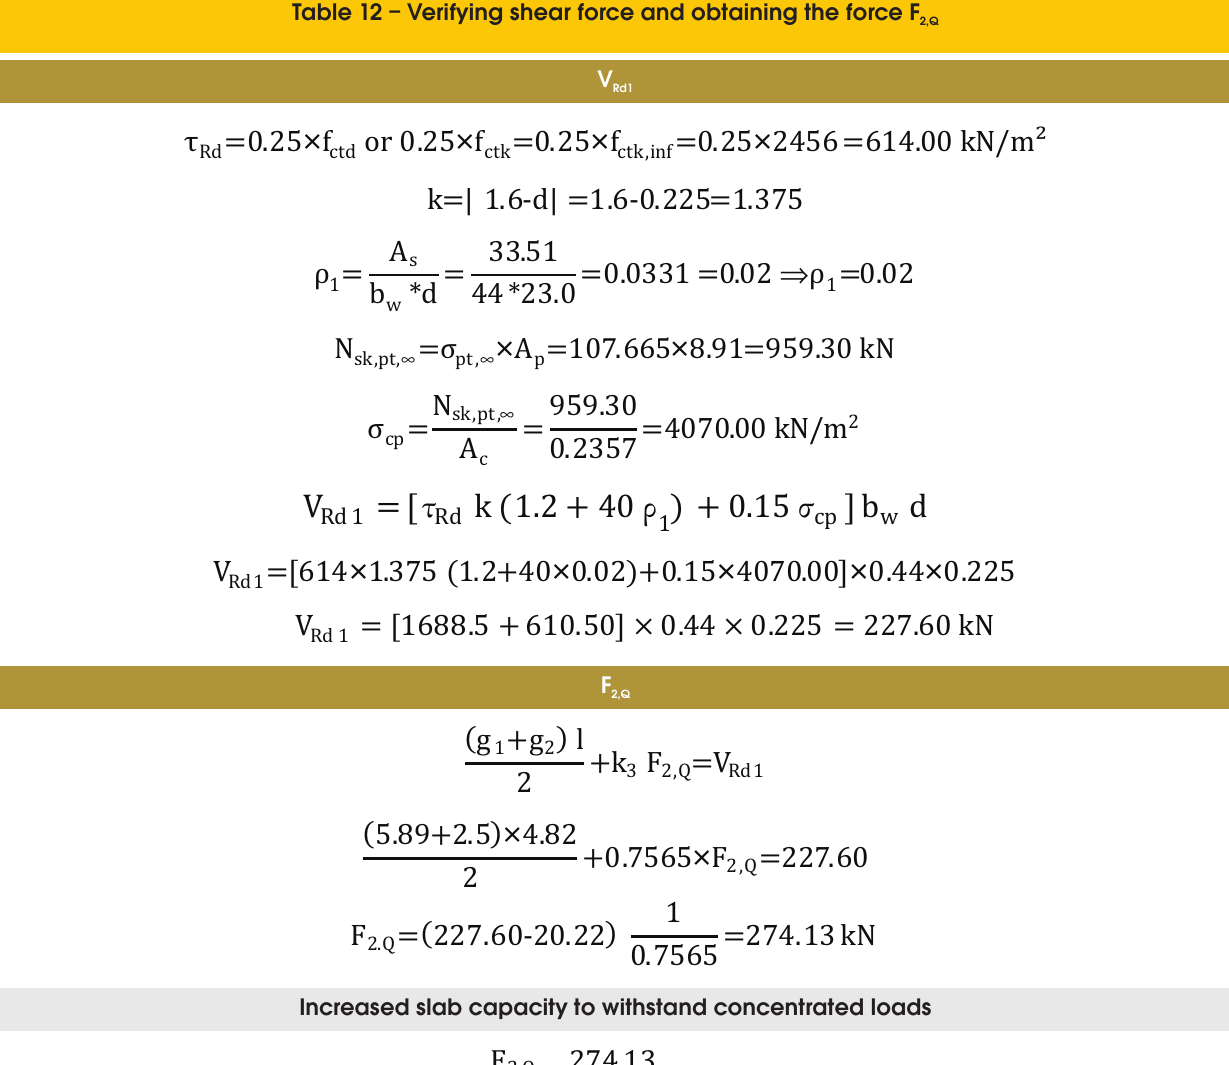
Table 12 – Verifying shear force and obtaining the force F